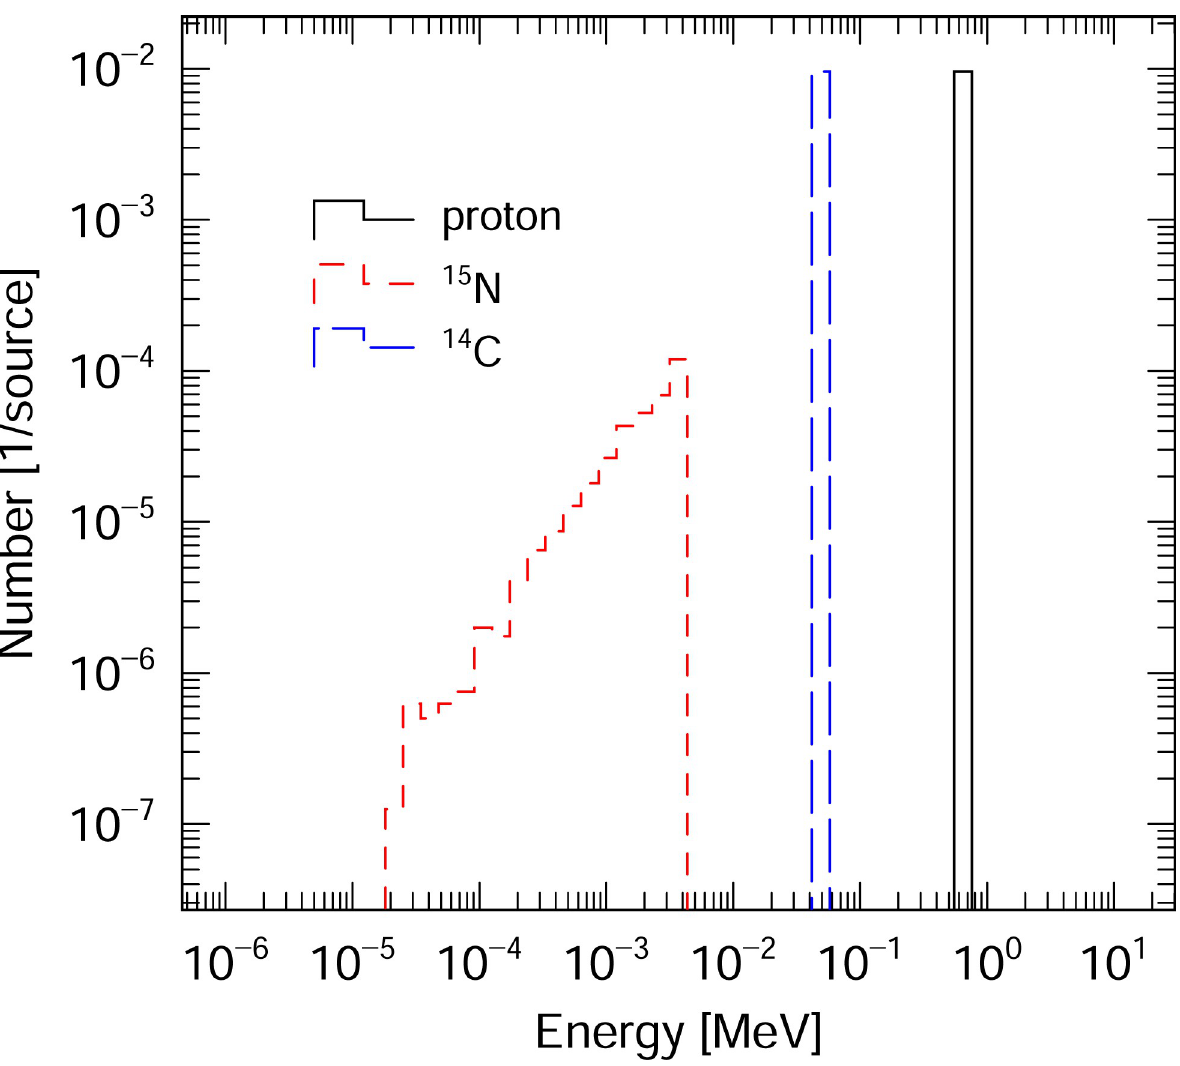
Fig 6. Recoil energy spectra produced by the reaction of 10 − 11 MeV neutrons incident on 14 N atoms.